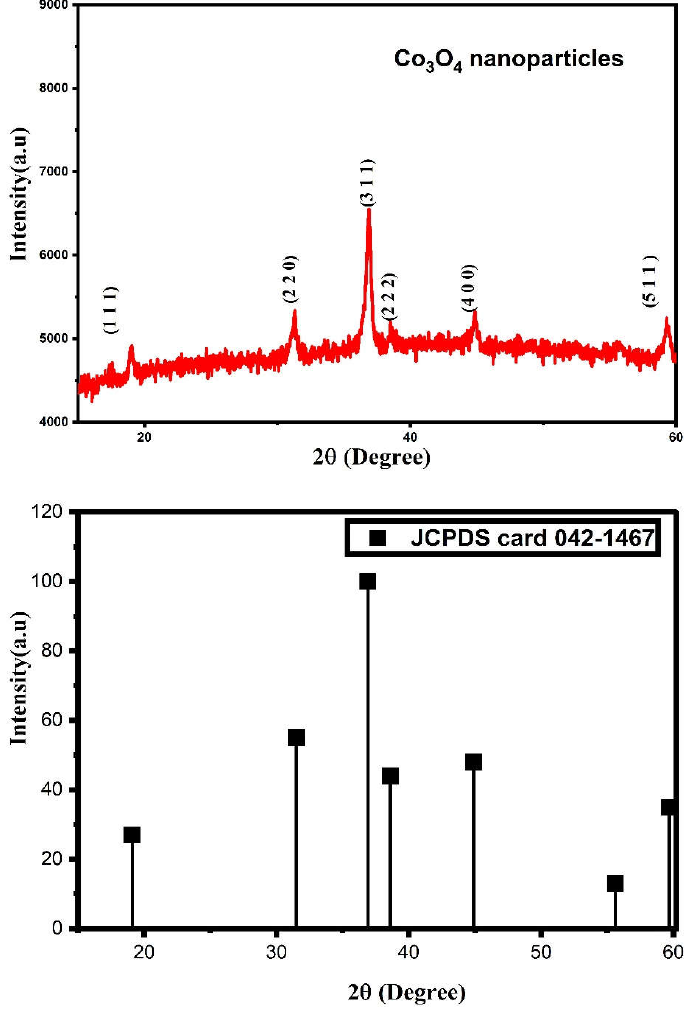
Figure 1. X-ray diffraction pattern of Co 3 O 4 nanoparticles.